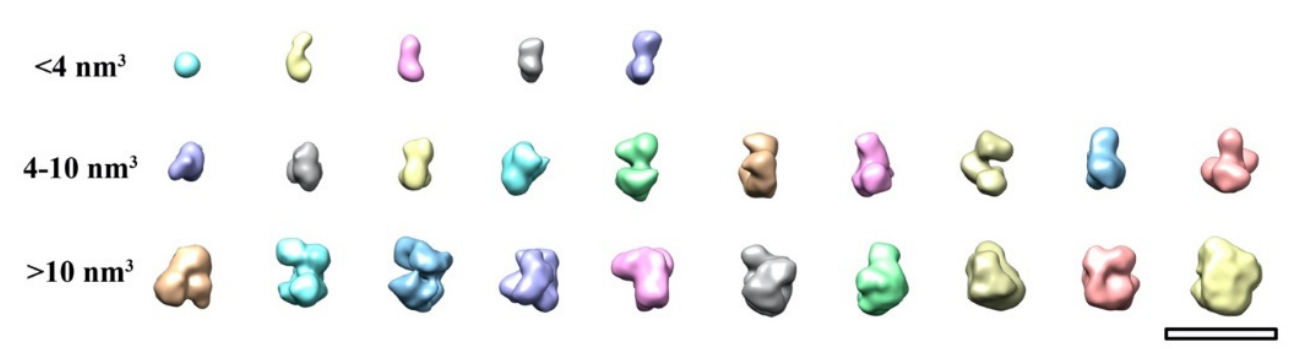
Figure 5. 3D classes demonstrating morphological diversity of iron clusters in Dps. The classes are arranged in ascending volume (left to right). Scale bar is 5 nm.